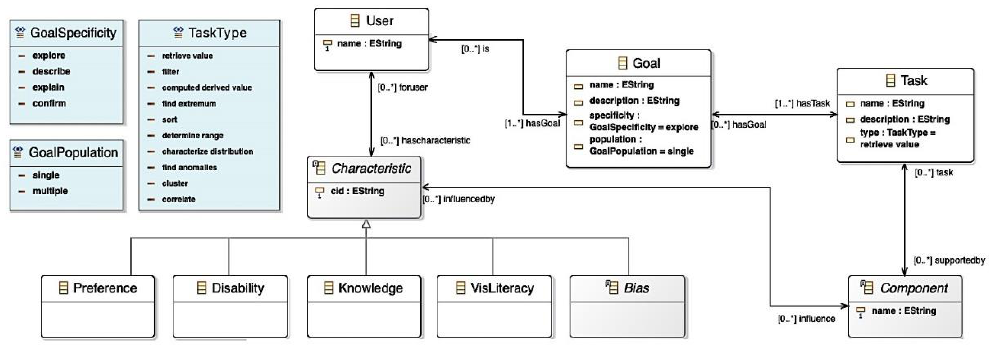
Figure 5. Extended user section of the meta-model. The rest of the meta-model has been omitted for legibility reasons. This image is available in high resolution at https://doi.org/10.5281/zenodo.3625703. Source: [57], licensed under CC BY 4.0.